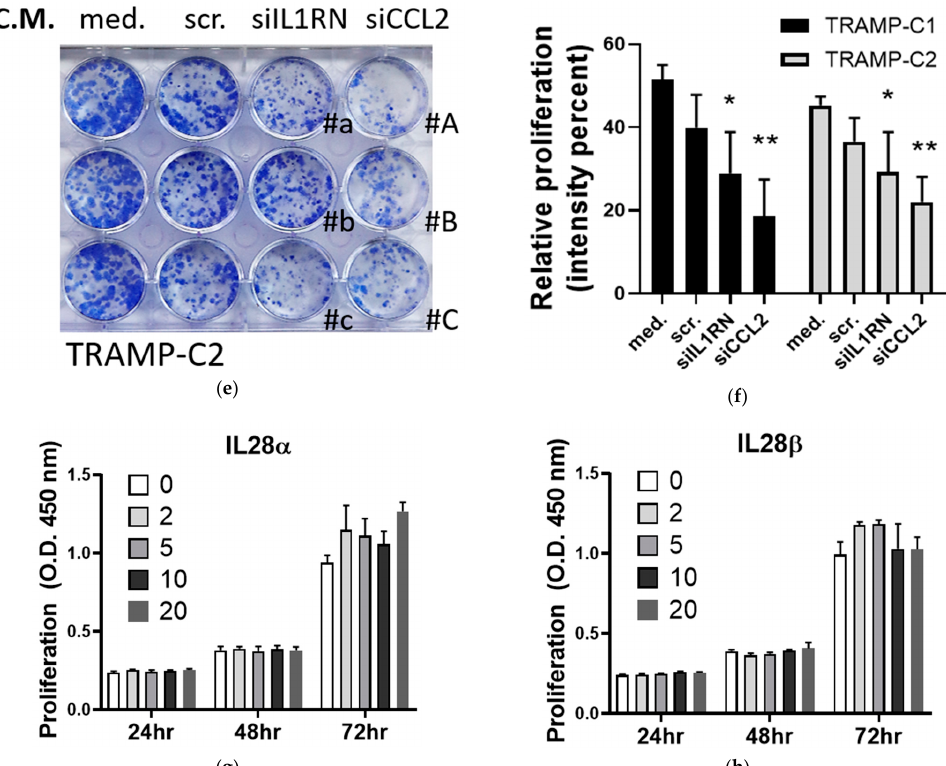
Figure 3. Anti-proliferation function of the conditioned media (C.M.) derived from the MSCs with knockdown of IL1RN and CCL2. ( a ) Differentiation of MSCs to adipocytes (oil red) and osteoblasts (Alizarin red S). MSCs without differentiation treatment serve as control (Ctrl). ( b ) Characterization of MSC markers using flow cytometry to detect several surface markers. Black: isotype antibody control. Red: specific antibody. ( c ) Confirmation of knockdown efficiency by measuring IL1RN and CCL2 protein secretion in the MSCs treated with respective siRNAs: siIL1RN (#a–#c) and siCCL2 (#A–#C). Protein secretion was measured by ELISA. (Ctrl vs. KOA-KOC) by ELISA; n = 3; med: fresh medium, scr: siRNA control. ( d , e ) Colony-formation assays using C.M. collected from the siRNA-treated MSCs in panel ( a ). C.M. was applied to TRAMP-C1 [panel ( d )] and TRAMP-C2 [panel ( e )]. ( f ) Colony numbers and staining intensities were quantified and compared; n = 3. ( g , h ) Proliferation analysis using TRAMP-C2 cell line in response to IL-28 α [panel ( g )] and IL-28 β [panel ( h )] recombinant proteins (ng/mL); n = 4. Student’s t -test. * p < 0.05. ** p < 0.01. **** p < 0.0001.